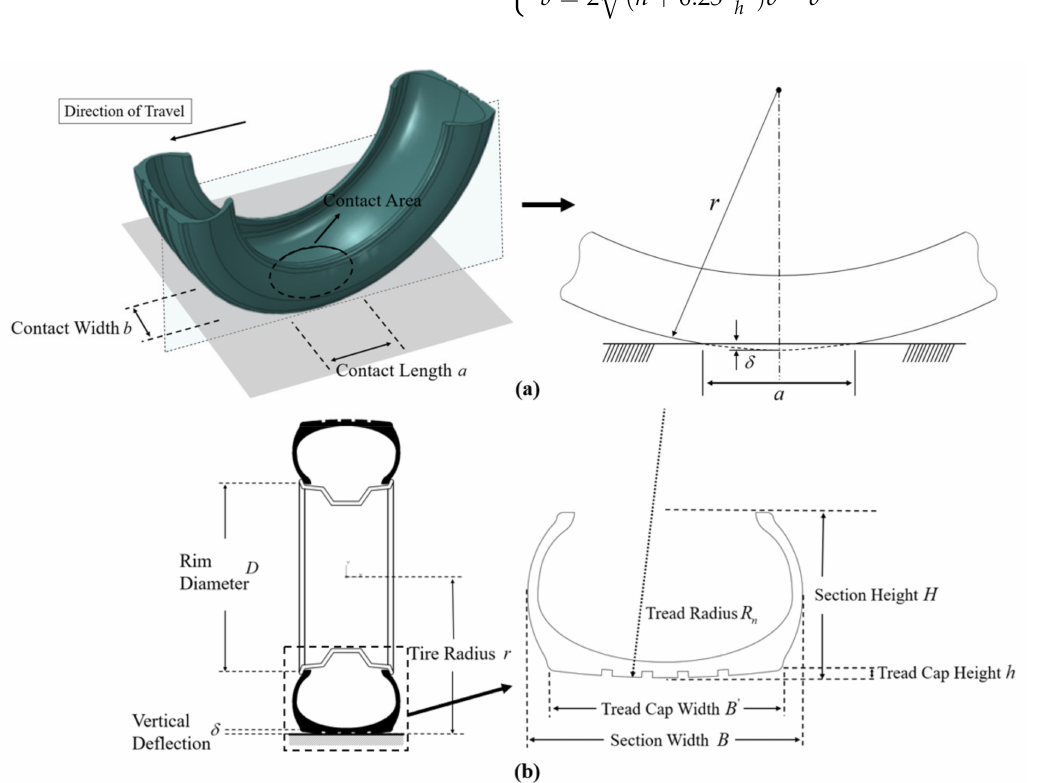
Figure 2. Tire geometry: ( a ) tire sideview; ( b ) tire